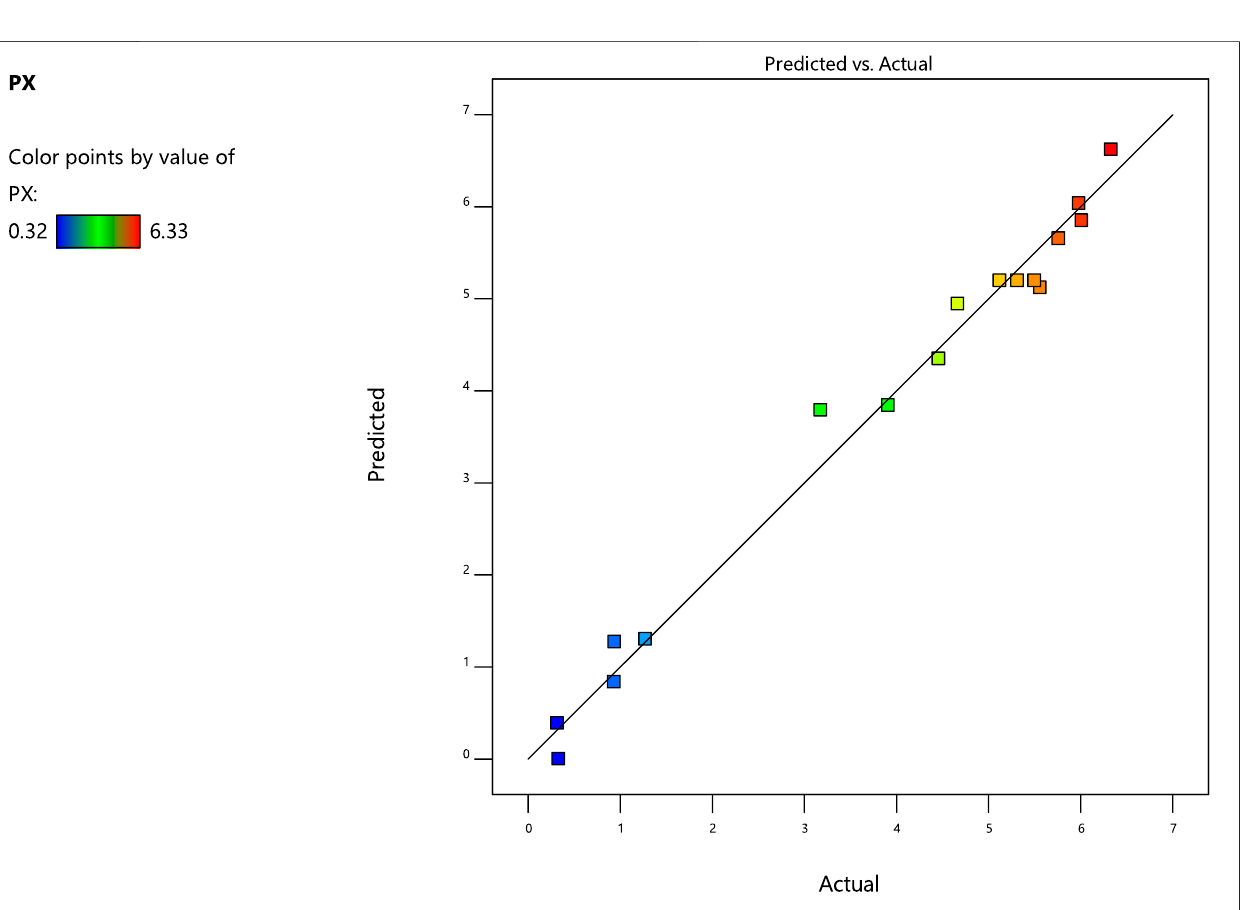
FIGURE 1 | Parity plot: showing the relation between actual response and predicted values for P X estimation.